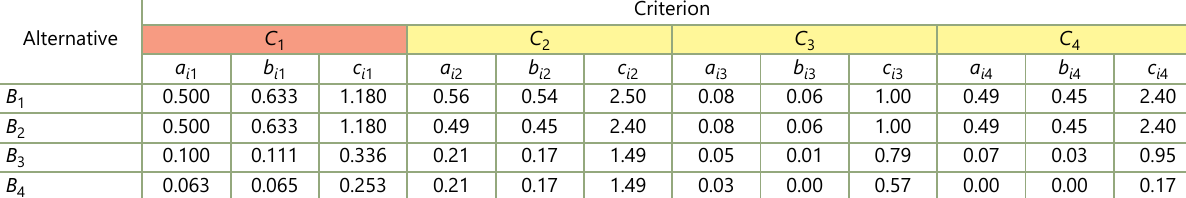
Table 16. The weighted normalized fuzzy decision matrix V G ( l ) for sensitive products ( l = 2) (source: own contribution)